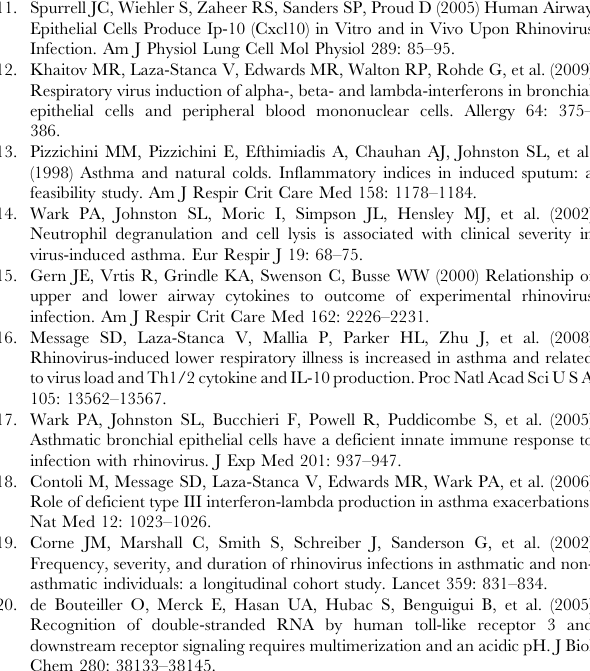
Figure S2 Role of TRIF and Cardif in RV1B induced pro- inflammatory cytokine gene expression in HBECs. (A) siRNA specific to TRIF and Cardif reduced RV1B induced rantes compared to control siRNA at 24h post infection. (B) siRNA specific to TRIF and Cardif reduced RV1B induced IP-10 compared to control siRNA at 24h post infection. (C) siRNA specific to TRIF and Cardif reduced RV1B induced IL-8 compared to control siRNA at 24h post infection. (D) siRNA specific to TRIF and Cardif reduced RV1B induced ENA-78 compared to control siRNA at 24h post infection. *** p , 0.001